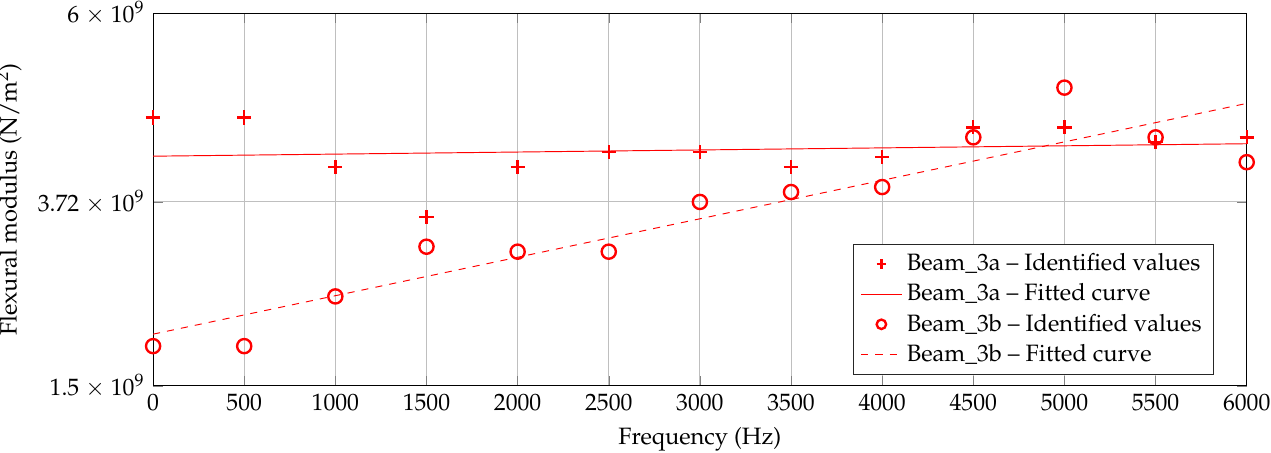
Figure 14. Identified flexural moduli by Figure 12 for Beam_3a/b with fitted linear curve.